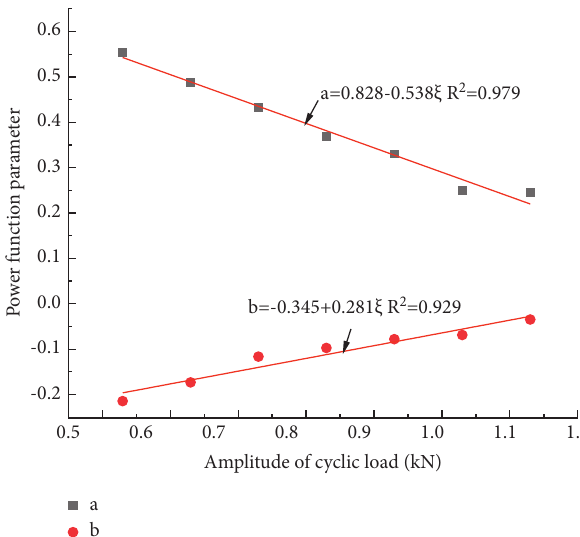
Figure 18: Variation law of power function model parameters with load amplitude.